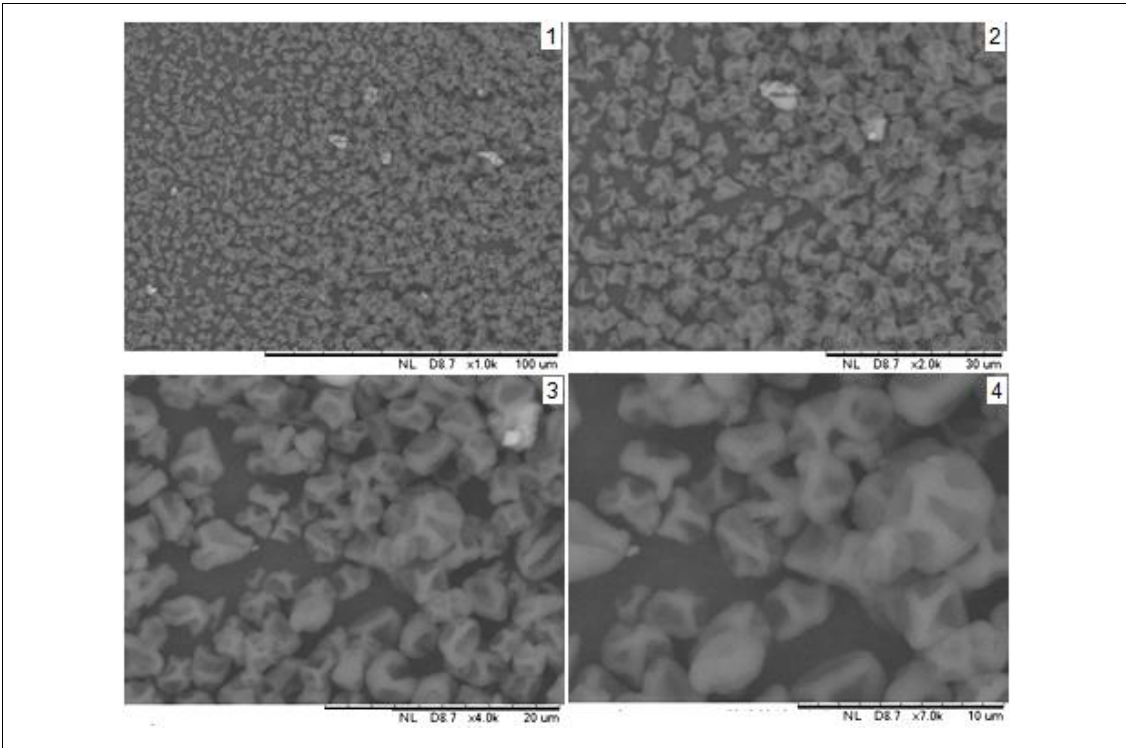
Figure 3. The SEM analysis results of microcapsule (Condition=Vacc=15.0kV). (1) 1.0k magnifications, 100 µm; (2) 2.0k magnifications, 50 µm; (3) 4.0k magnifications, 20 µm; and (4) 7.0k magnifications, 10